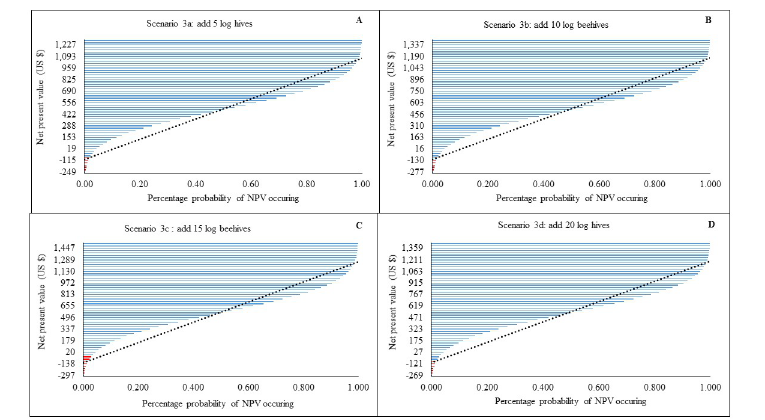
Fig 4. Modelled probability (%) changes in Net Present Value (NPV) for changing log hive numbers (scenarios 4a- d). Income changes following addition of log hives. Red lines indicate loss and blue lines profit. Dotted black line is a linear forecast. NPVs to the right of the line indicate optimal profit/loss attained for each an intervention level.